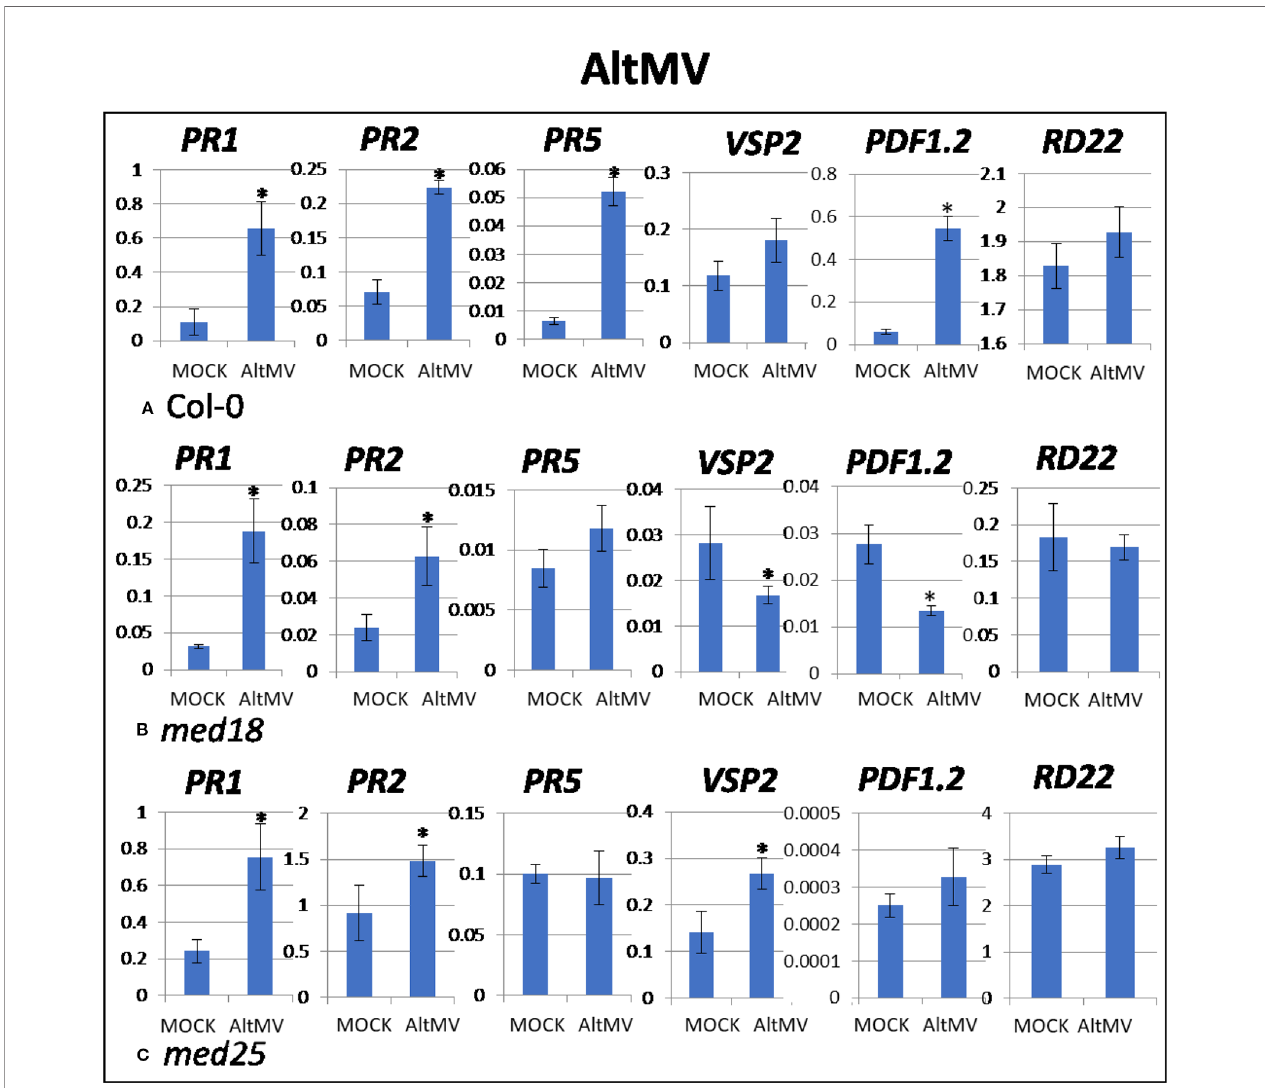
FIGURE 4 | Quantitative reverse transcriptase PCR (qRT-PCR) assays with SA- ( PR1, PR5 ), JA- ( PDF1.2, VSP2 ), and ABA- ( RD22 ) signaling marker genes of Arabidopsis plants inoculated with AltMV. Shown on the Y axes are mean ± SE values of transcript abundances relative to ACTIN housekeeping genes for (A) wild- type Col -0, (B) med18 , and (C) med25 plants at 2 days after inoculation. Asterisks indicate signi fi cant ( P < 0.05) induction or repression of each gene by comparing the means of mock-inoculated to Alternanthera mosaic virus (AltMV) – infected